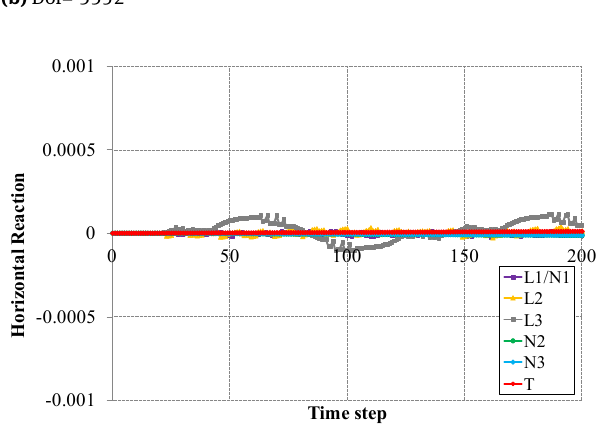
Figs.20aandb.ThecurvesobtainedwithT-splinesapprox-